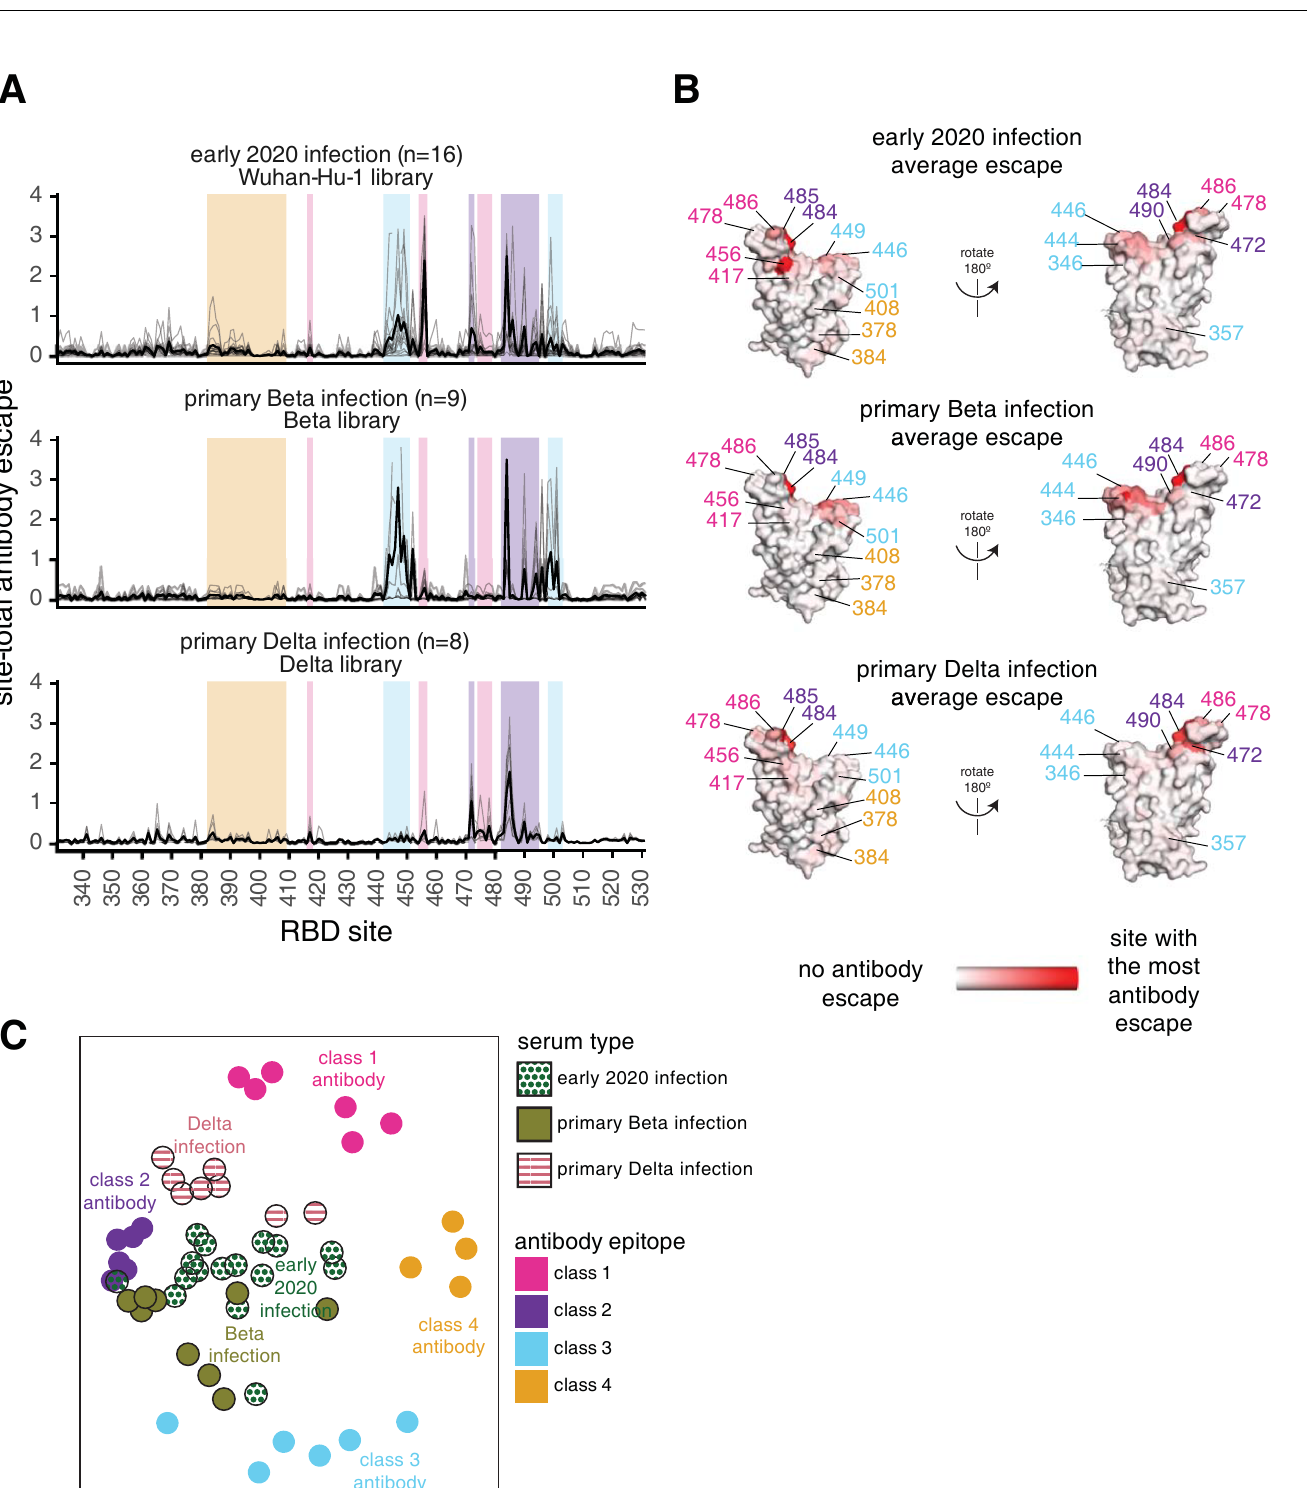
Fig 4. Antibody-escape maps for individuals infected with early 2020 viruses, Beta, or Delta. (A) Site-total antibody escape averaged across each group of plasmas for early 2020, Beta, and Delta convalescent plasmas, with key epitope regions highlighted (key in panel C). (B) Site-total antibody escape averaged across each group mapped to the Wuhan-Hu-1 RBD surface (PDB 6M0J, [64]), with red indicating the site with the most antibody escape and white indicating sites with no escape. Key antibody-escape sites are labeled, with site labels colored according to epitope. (C) Multidimensional scaling projection with the distance between points representing the dissimilarity between antibody-escape maps for individual early 2020, primary Beta, and primary Delta infection convalescent plasmas, with monoclonal antibody escape maps of the 4 classes used as anchors. In all panels, the convalescent plasmas were mapped against RBD mutant libraries corresponding to the viral variant of exposure. The antibody-escape maps for early 2020 infections were first reported in [23,24],the Beta infections in [12], and the monoclonal antibodies in